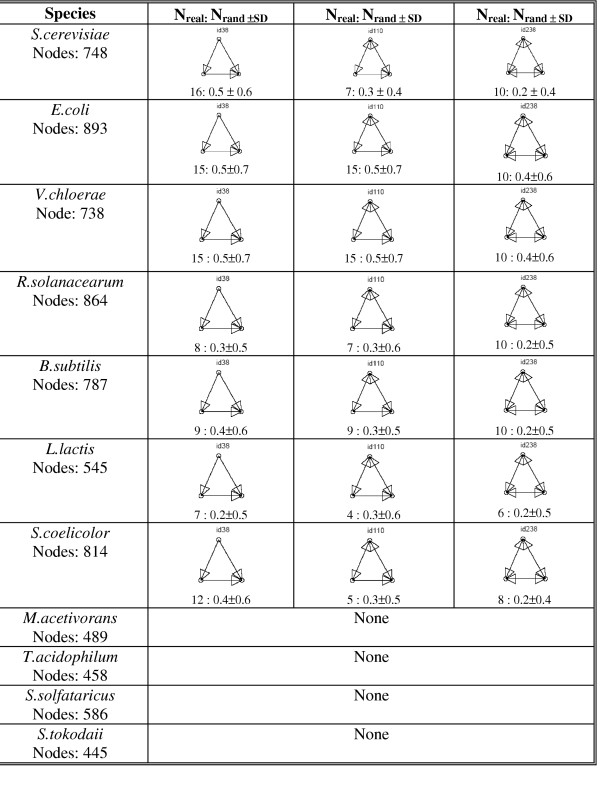
Three-node motifs found in the metabolic networks in different species. The number of connecting nodes for each network is shown. For each motif, the numbers of appearances in real networks (Nreal) and in randomized networks (Nrand ± SD, all values rounded) are shown. The p-values of all motifs are less than 0.01, as determined by comparing to 1000 randomized networks. Each motif occurs at least four times in one network. Motifs were detected and generated using program developed by Milo et al. (2002) and the motif dictionary therein [15].